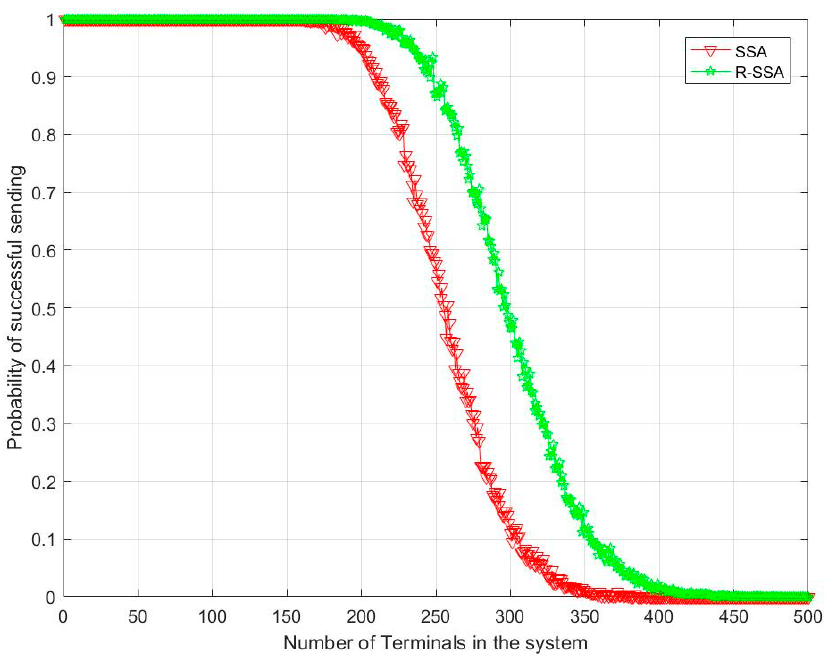
Figure 15. R-SSA vs. SSA in the probability of successful sending.